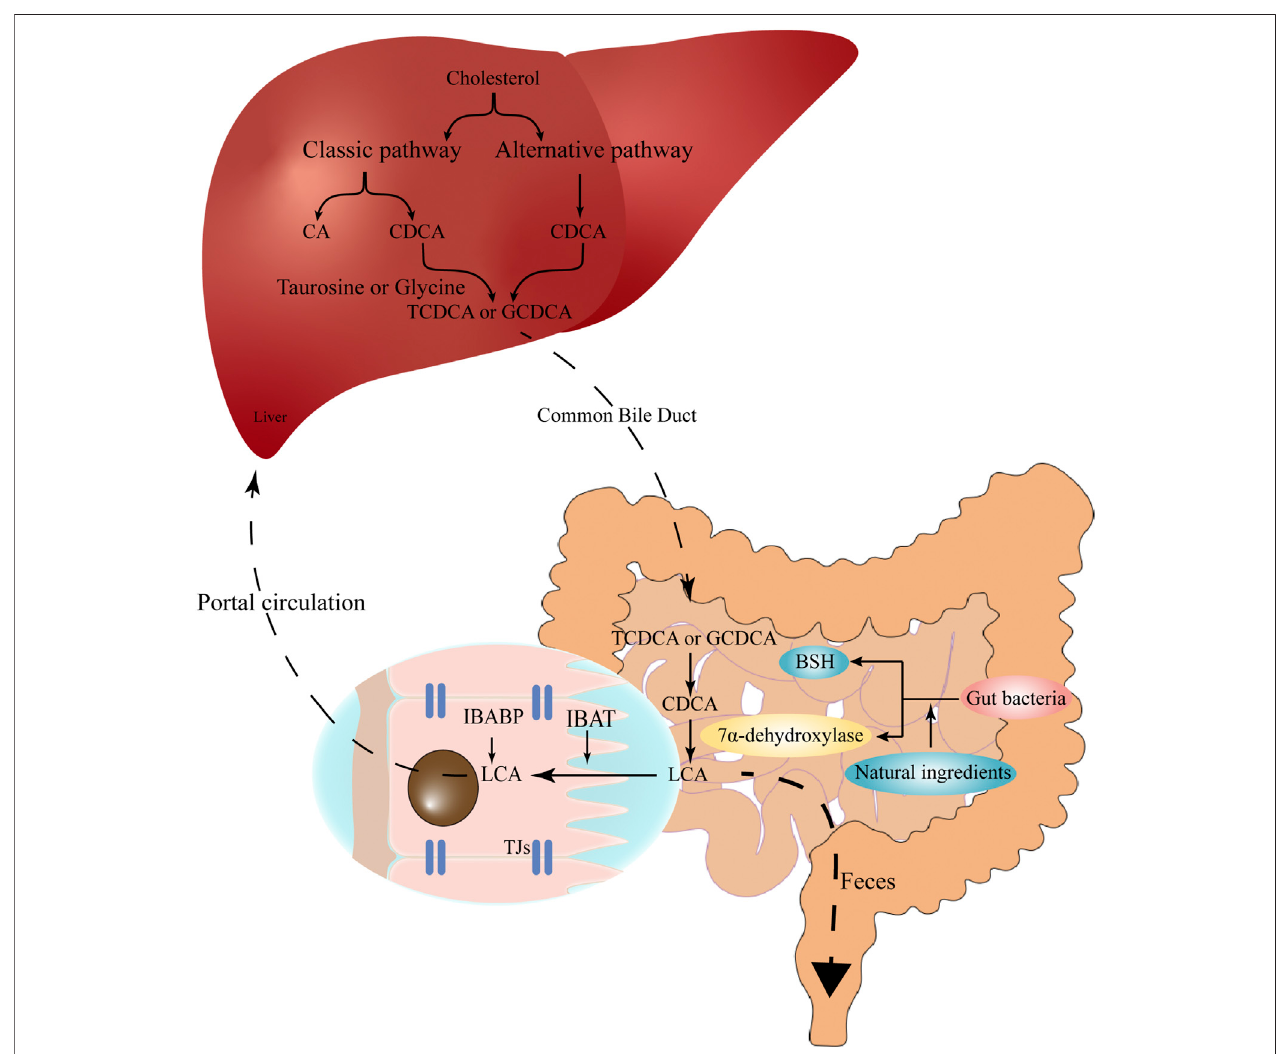
FIGURE1| Thesynthesisandenterohepatic circulationofLCA.Cholesterolisconverted intoprimaryBAs(CAandCDCA)undertheactionofCYP7A1,CYP27A1, CYP8B1andrelatedenzymesinhepatocytes.PrimaryBAsconjugatewithtaurineorglycine,temporarilystoreinthegallbladder,andthenareexcretedintothegutupon food intake. In the gut, the conjugated BAs are subsequently uncoupled by gut bacteria and converted to secondary BAs (e.g., LCA) via 7 α -dehydroxylation. The high- af fi nity IBAT actively transports conjugated and unconjugated LCA from the intestinal lumen to the ileocytes, where they are bound to IBABP and eventually exported across thebasementmembrane totheportal circulation and back tothe liver. Natural ingredientscanup-regulate theexpression ofbilesalt hydrolase and 7 α - dehydroxylation, therefore promote the production of LCA. LCA, lithocholic acid; BAs, bile acids; CA, cholic acid; CDCA, chenodeoxycholic acid; CYP7A1, cholesterol 7 α -hydroxylase; CYP27A1, sterol 27-hydrolase; CYP8B1, 24-hydroxycholesterol-7 α -hydroxylase; IBAT, intestinal bile acid transporter; IBABP, ileal bile acid binding protein.